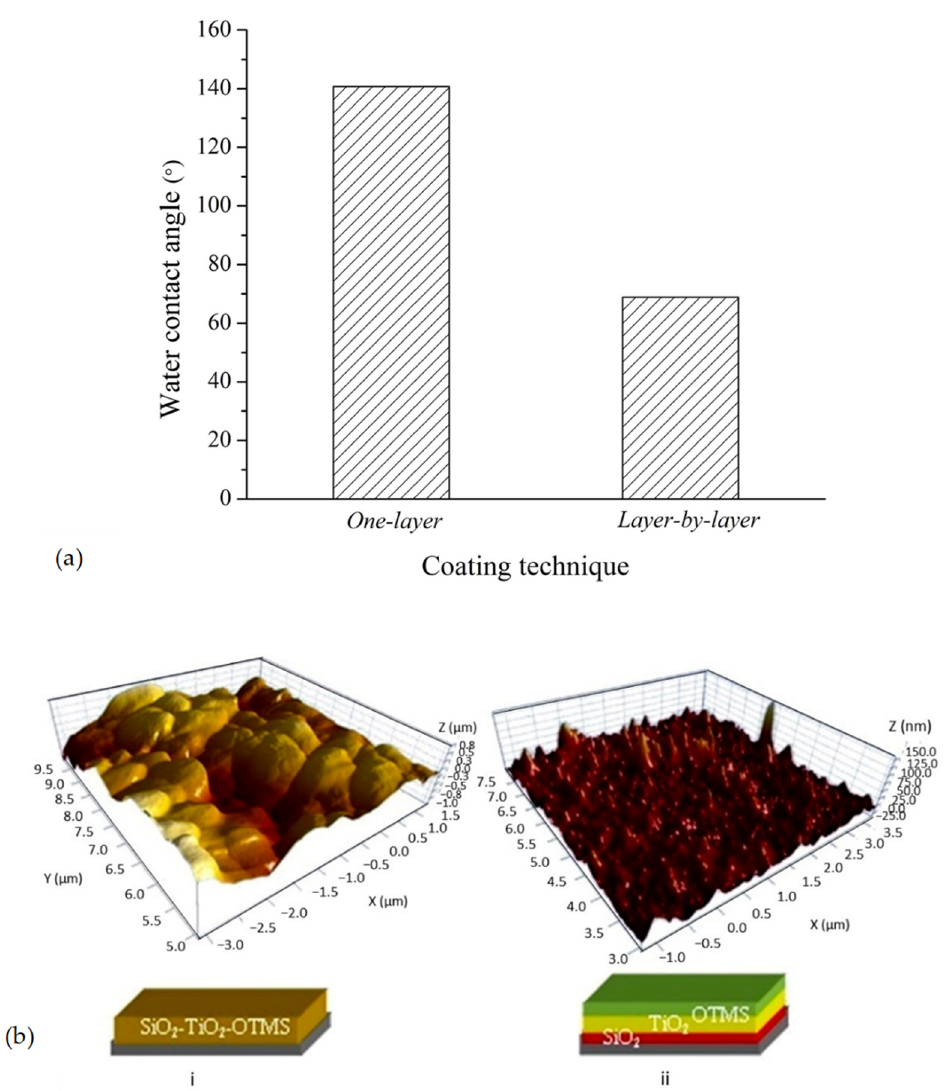
Figure 14. ( a ) The correlation between water contact angle and the coating technique of SiO 2 , TiO 2 , and OTMS-coated glass. ( b ) The AFM images of SiO 2 , TiO 2 , and OTMS-coated glass were prepared using ( i ) one layer and ( ii ) layer-by-layer coating